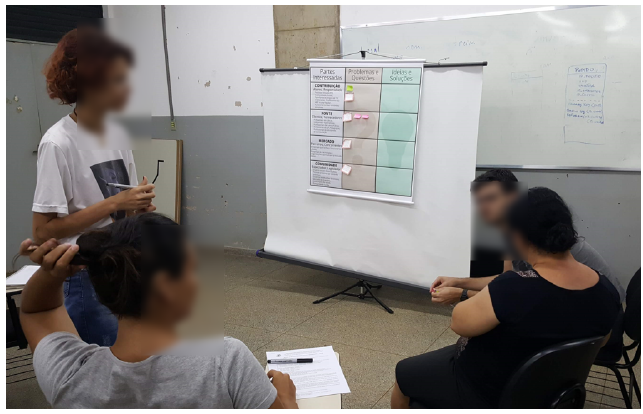
Fig. 5. Context and participants of the 2nd SWP: Evaluation Frame (A7) III shows participants’ responses problems/questions